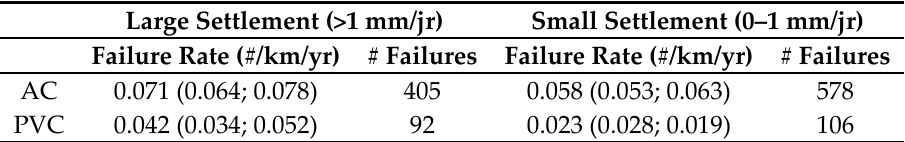
Figure 5. Maximum differential settlement obtained from satellite data compared to the calculated joint rotation ( a ) and pipe stresses ( b ). Each point represents a pipe in the distribution network considered in the analysis. Table 1. Effect of settlements (obtained by satellite data) on failure rates. The brackets show the 95% uncertainty boundaries of the failure